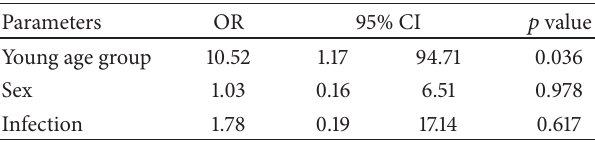
Table 2: Multivariable odds ratios (OR) and 95% confidence inter- val (CI) of potential factors affecting recurrence of antrochoanal